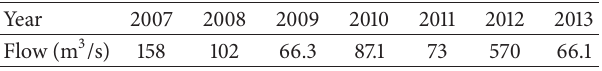
Table 2: Annual instant maximum flows of Mert